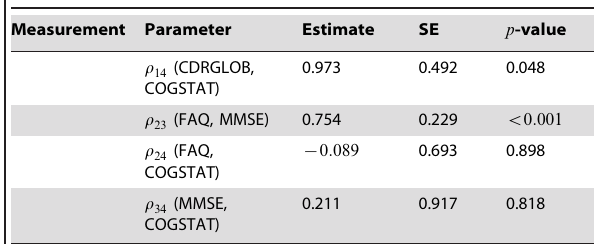
Table 1. Cont. Measurement Parameter